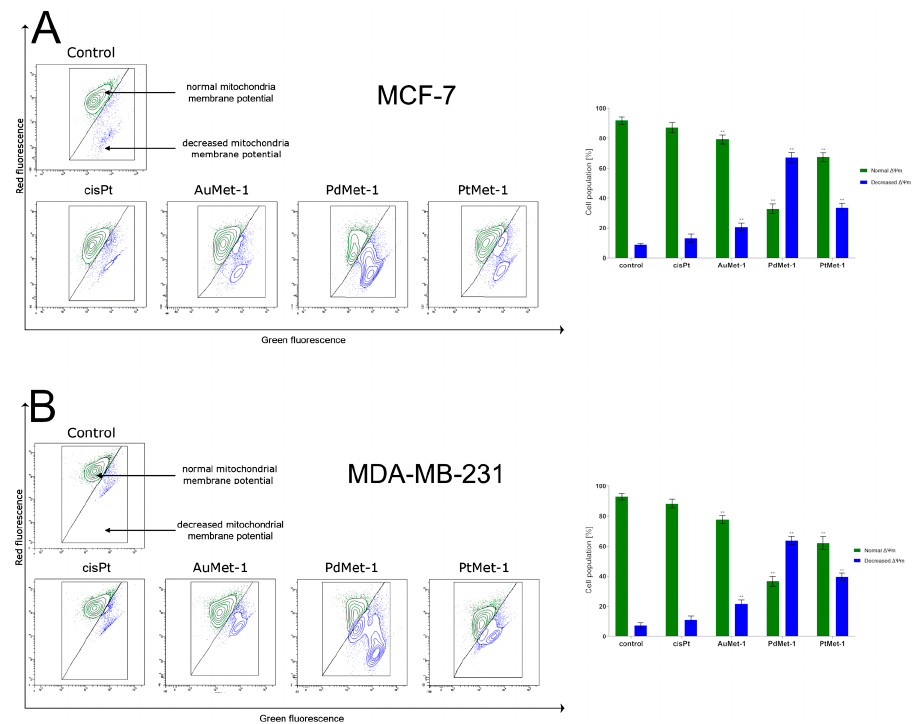
Figure 4. Fluorescence of MCF-7 ( A ) and MDA-MB-231 ( B ) breast cancer cells treated for 24 h with AuMet-1, PdMet-1, PtMet-1 and cisplatin (50 µM) incubated with mitochondrial membrane potential probe JC-1. Mean percentage values from three independent experiments (n = 3) done in duplicate are presented. * p < 0.05 vs. control group, ** p < 0.01 vs. control group. 2.4. AuMet-1, PdMet-1 and PtMet-1 Induce Autophagy